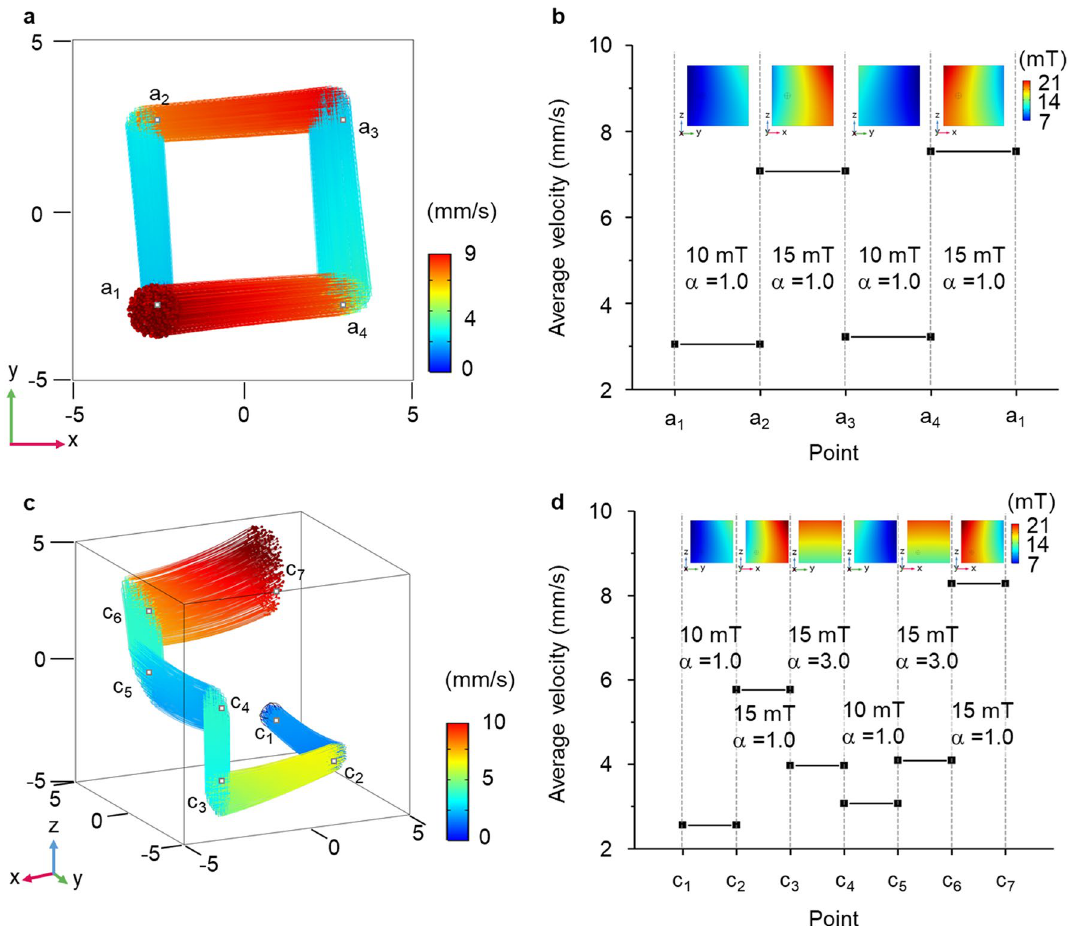
Figure 4. Spatial control of the nanorobot cluster with various magnetic fields according to the change in parameter α. ( a ) Two-dimensional control of nanorobot cluster. The colors represent the velocity of the nanorobot cluster. ( b ) The average velocity of the nanorobot cluster while traveling. ( c ) Three-dimensional control of nanorobot cluster. ( d ) The average velocity of the nanorobot cluster while traveling (COMSOL Multiphysics